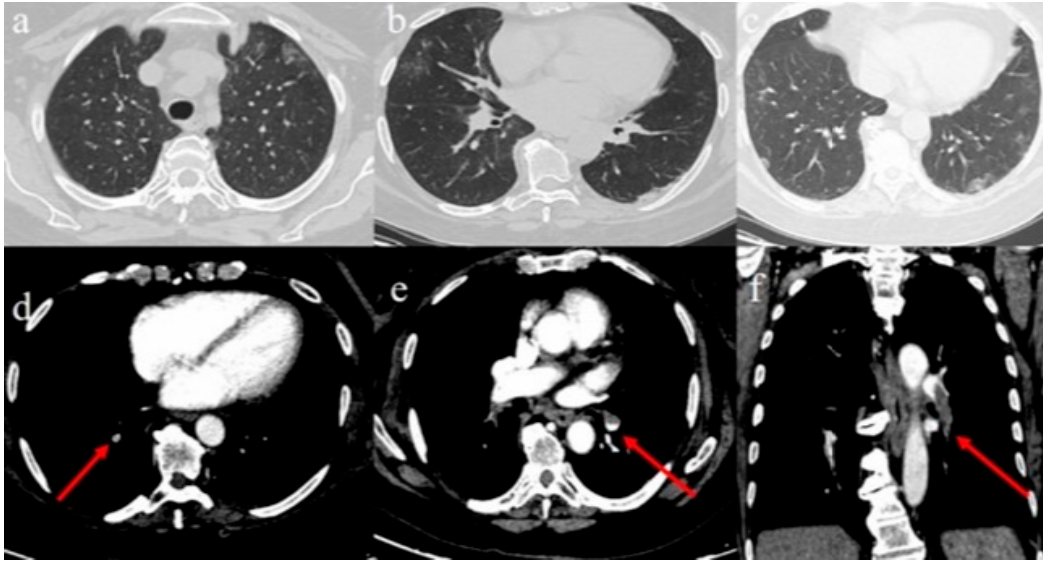
Figure 1. Chest computed tomography (CT) and CT angiography (CTA) of Case 1. Lung window (W: 1600 UH, L: − 500 UH) of chest CT scan: findings of COVID-19 pneumonia with peripheral ground-glass opacities in the left superior lobe ( a ), in the middle lobe, with a posterior peripheral consolidation in the inferior left lobe ( b ); peripheral ground-glass opacities in the inferior lobes ( c ). Mediastinal window (W: 251 UH, L: 45 UH) of CTA scan: filling defect in a right subsegmental pulmonary artery branch for the inferior lobe (red arrow in ( d )); an extensive filling defect in the lobar and in a segmentary pulmonary arterial branch for the inferior lobe (red arrow in ( e ) on the axial plane and in ( f ) on the coronal plane).